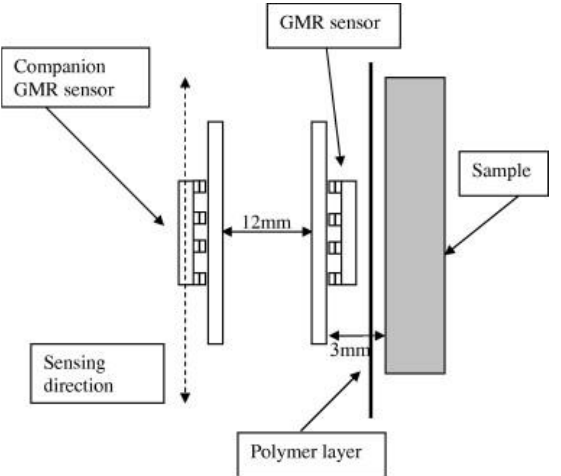
Figure 16. Scheme of the side view of the sensor setup (reproduced with permission from Refer- ence